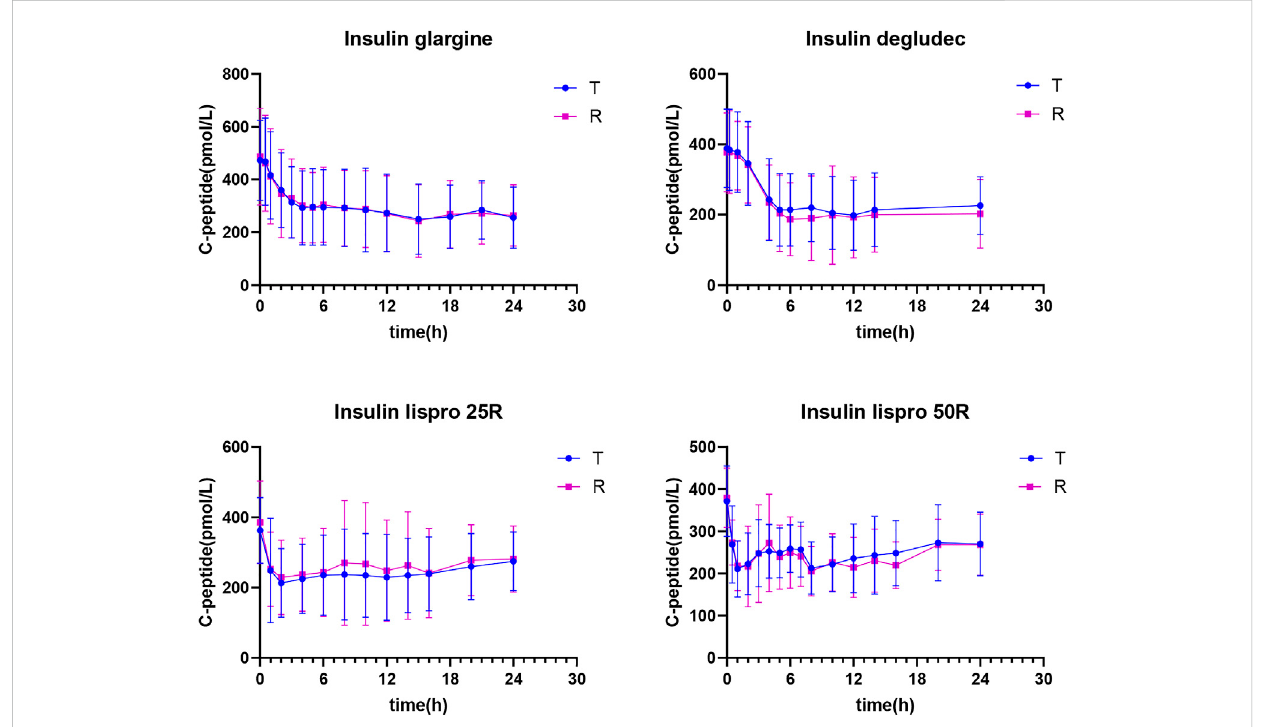
FIGURE 2 Mean C-peptide concentration versus time pro fi les after insulin biosimilar administration in healthy